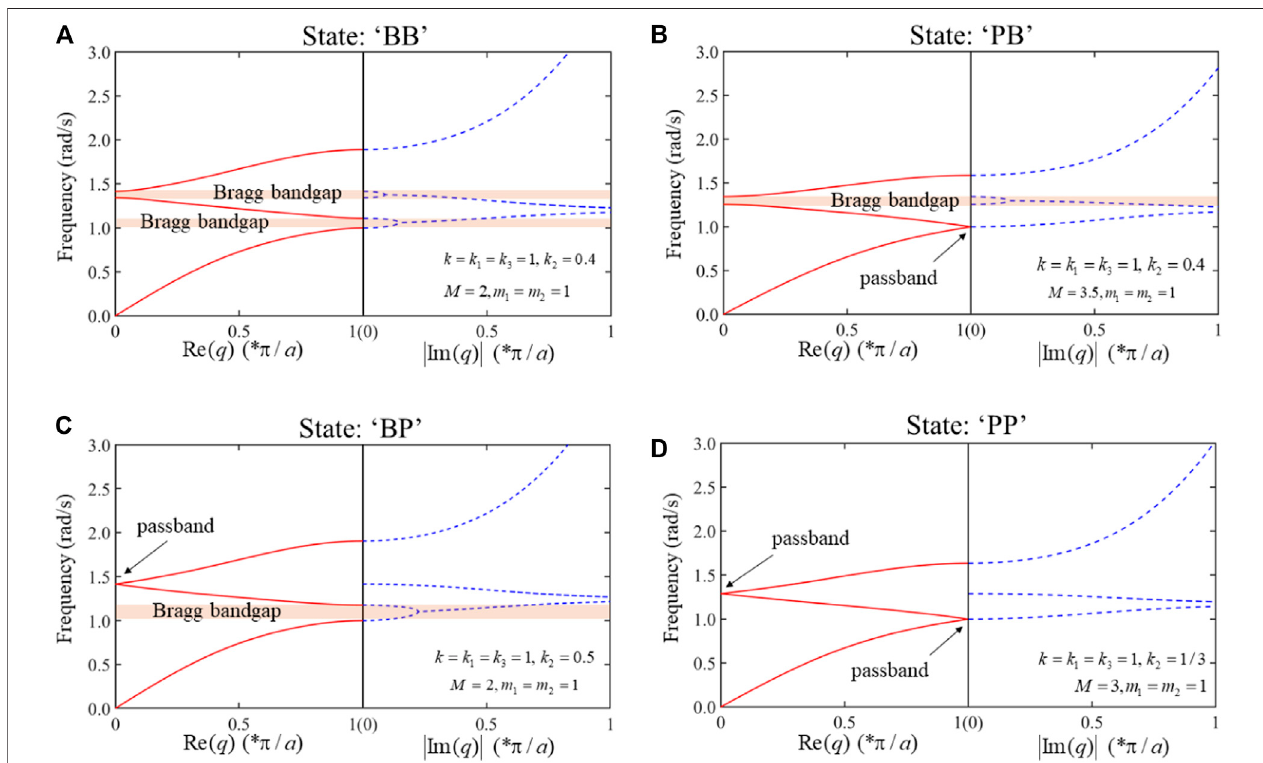
FIGURE 5 | Different bandgap states when anti-resonant frequencies are absent in the mass-coupled monatomic/triatomic chain system. (A) State “ BB ” : the fi rst andsecondbandgapsareBraggbandgaps. (B) State “ PB ” :the fi rstBraggbandgapcloses. (C) State “ BP ” :thesecondBraggbandgapcloses. (D) State “ PP ” :both fi rst and second bandgaps